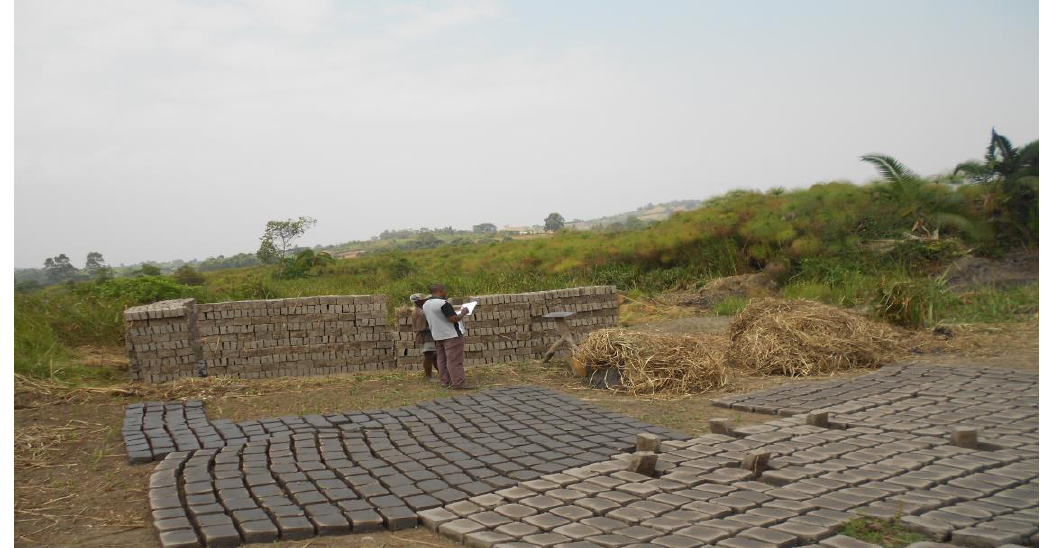
Fig. 3. Bricks that have been made using clay mined from the wetland by one of the members of the local communities in the Central Region, Rusoke,